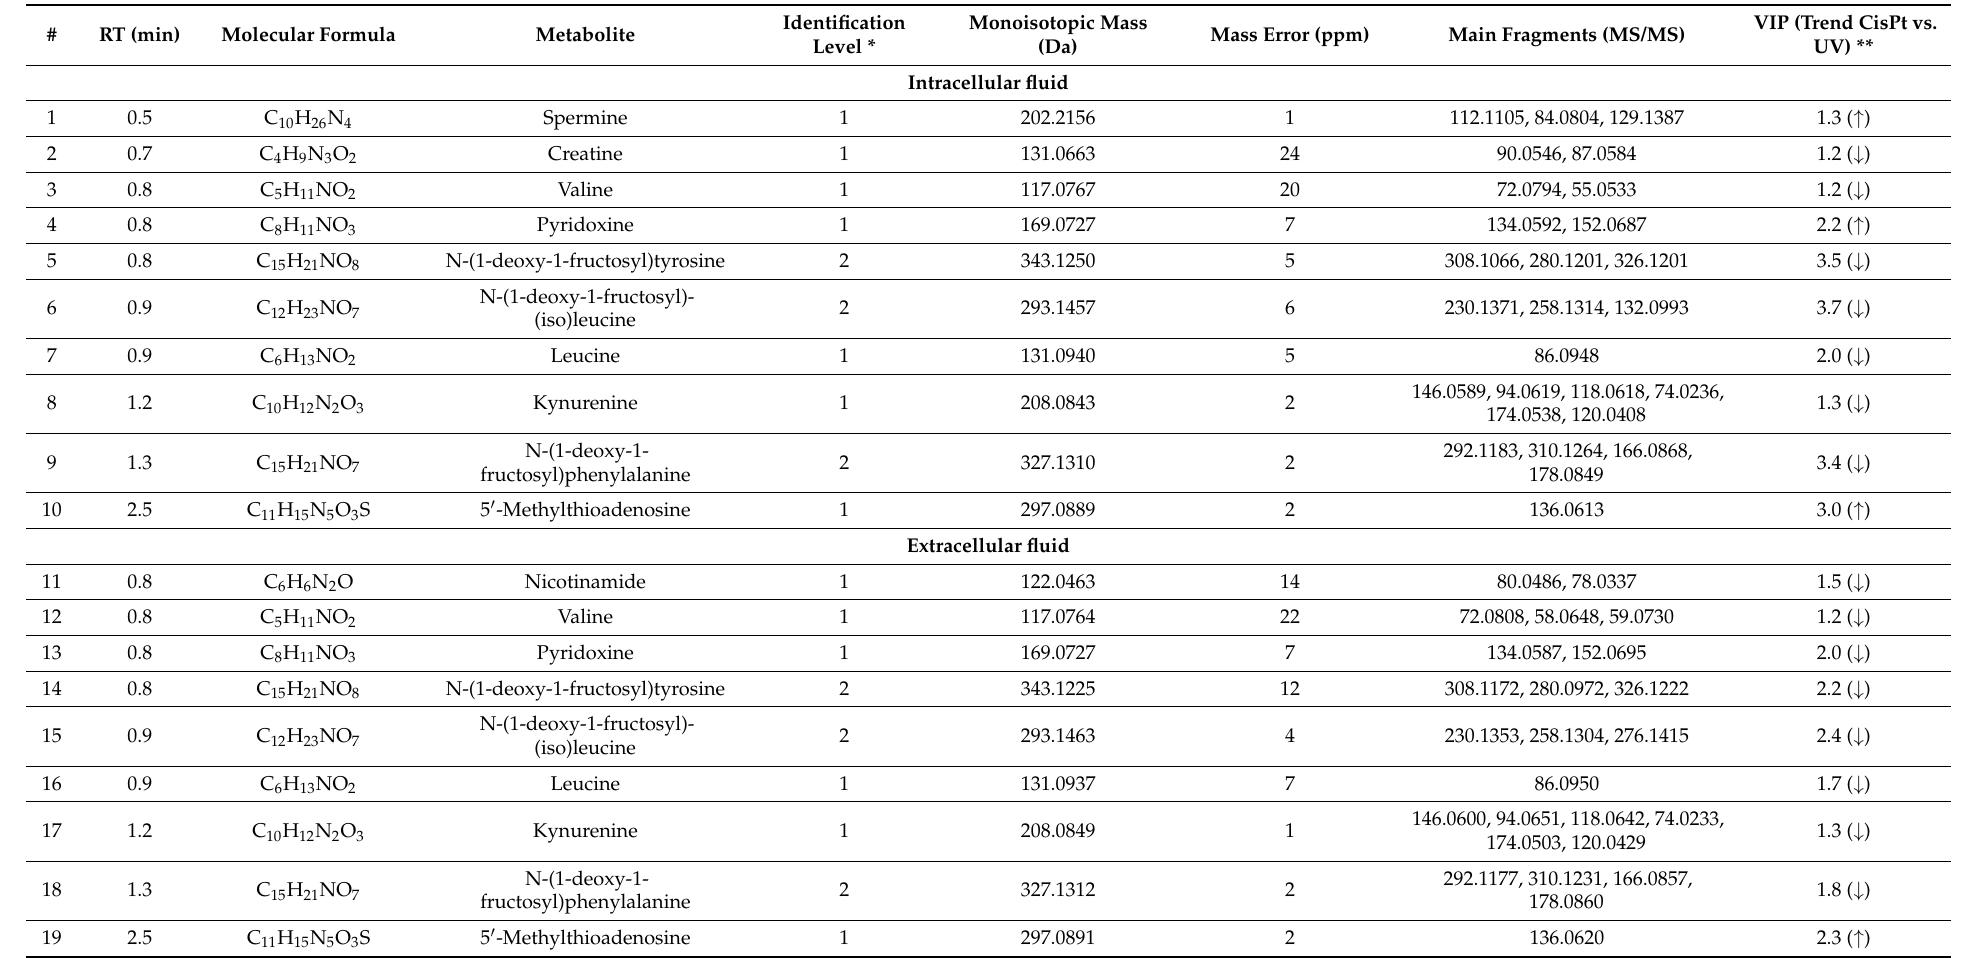
Table 1. Metabolites identified in the Abs and extracellular fluid analyses by the RPLC-MS metabolomics